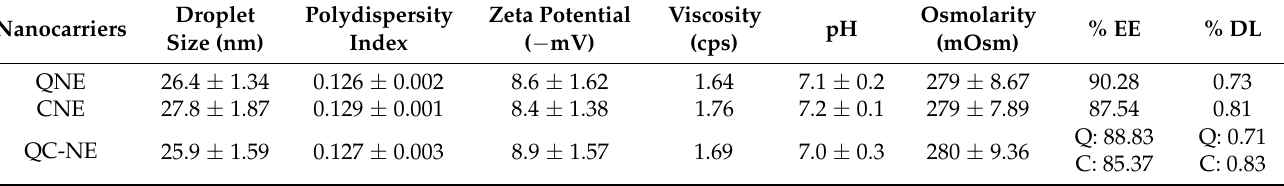
Table 1. Characteristics of nanocarrier systems meant for intravenous administration.